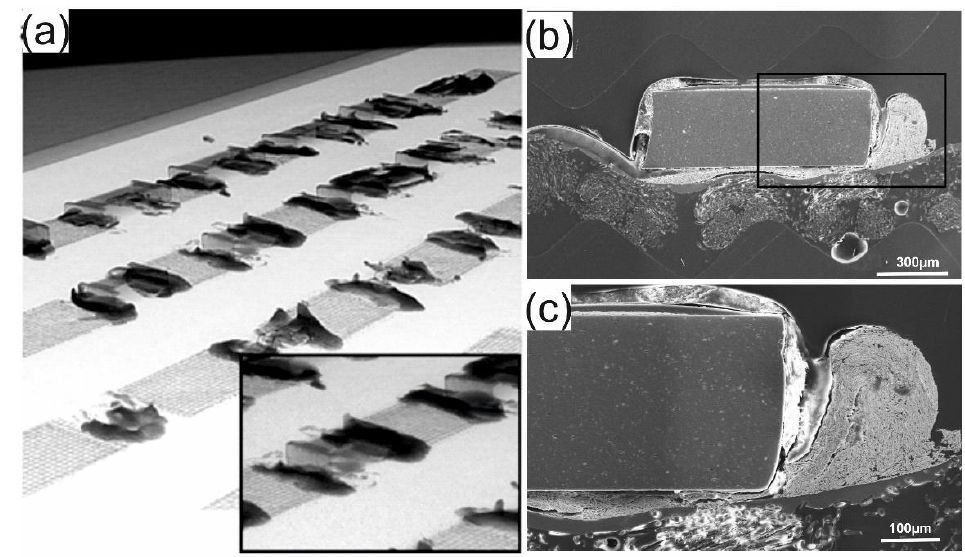
Figure 2. X-ray micrographs of resistors picked and placed on textile ( a ), SEM-micrographs of the cross-section of a resistor on textile ( b ). Zoom-in of the black framed region in ( b ) of the contact area resistor textile ( c ).